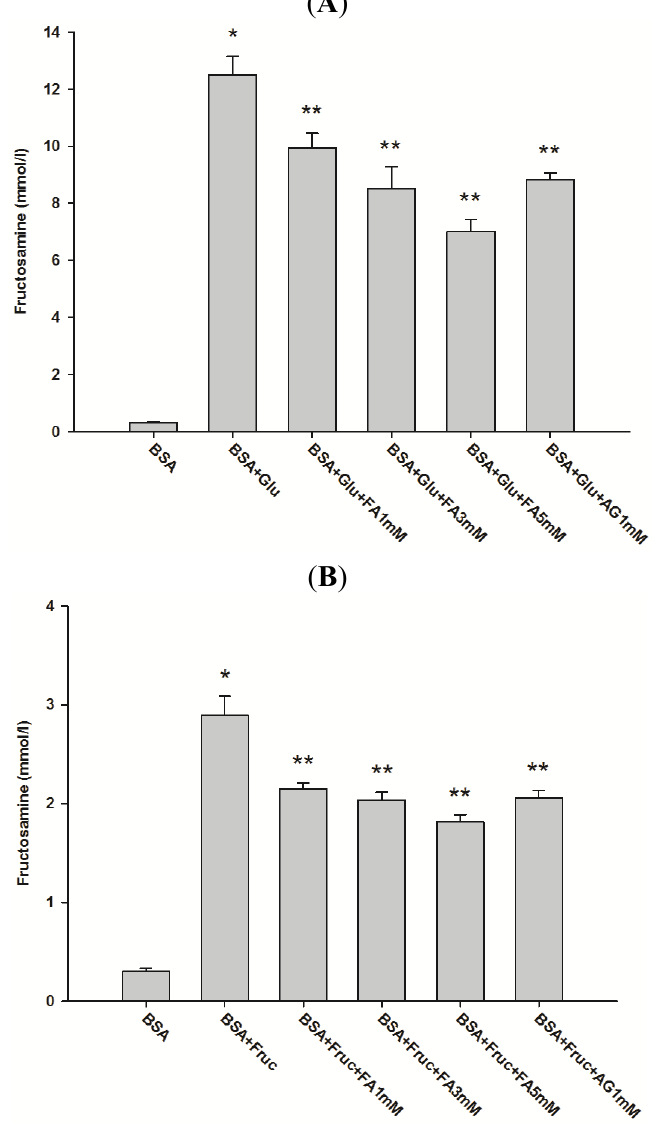
Figure 4. Effect of FA on fructosamine level in BSA incubated with glucose ( A ), fructose ( B ) and ribose ( C ) at week 4. The results are expressed as mean ± SEM ( n = 3). * p < 0.05 when compared to BSA, ** p < 0.05 when compared to BSA+glucose, BSA+fructose or BSA+ribose. AG was used as positive